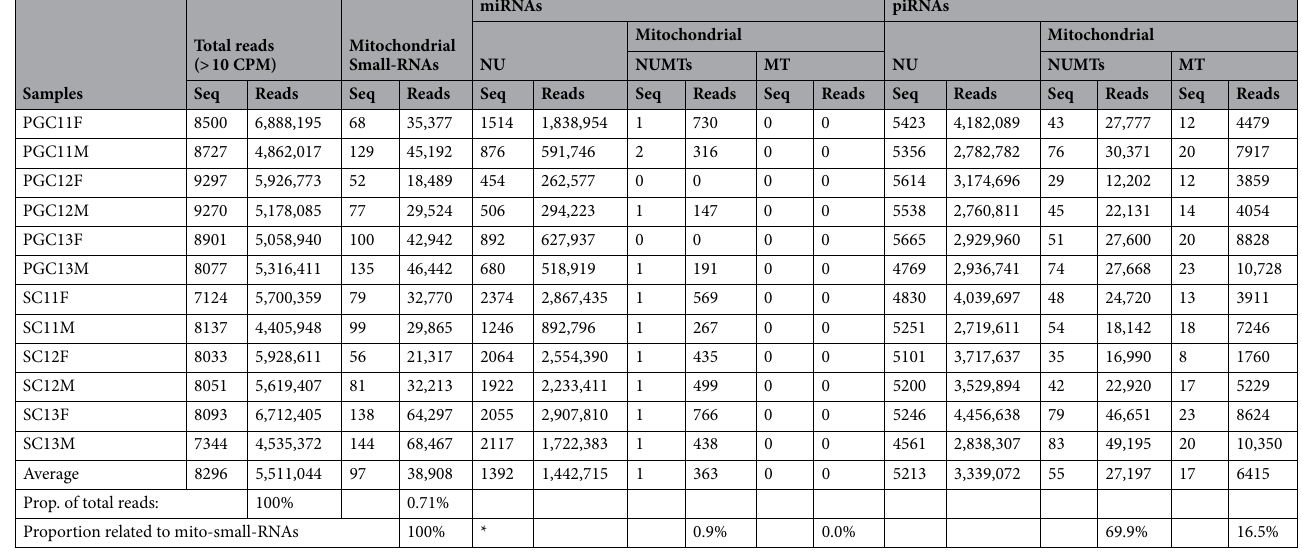
Table 1. Summary of unique the sequences (Seq) and reads (Reads) of sncRNAs mapping to genetic mitochondrial features, matching with miRNA and piRNA databases, differentiating those that map exclusively to the nuclear genome (NU), exclusively to the mitochondrial genome (MT), or to both genomes (NUMT). Note that (*) indicates other sncRNAs that, mapping to mitochondrial sequences, do not only correspond to miRNAs or